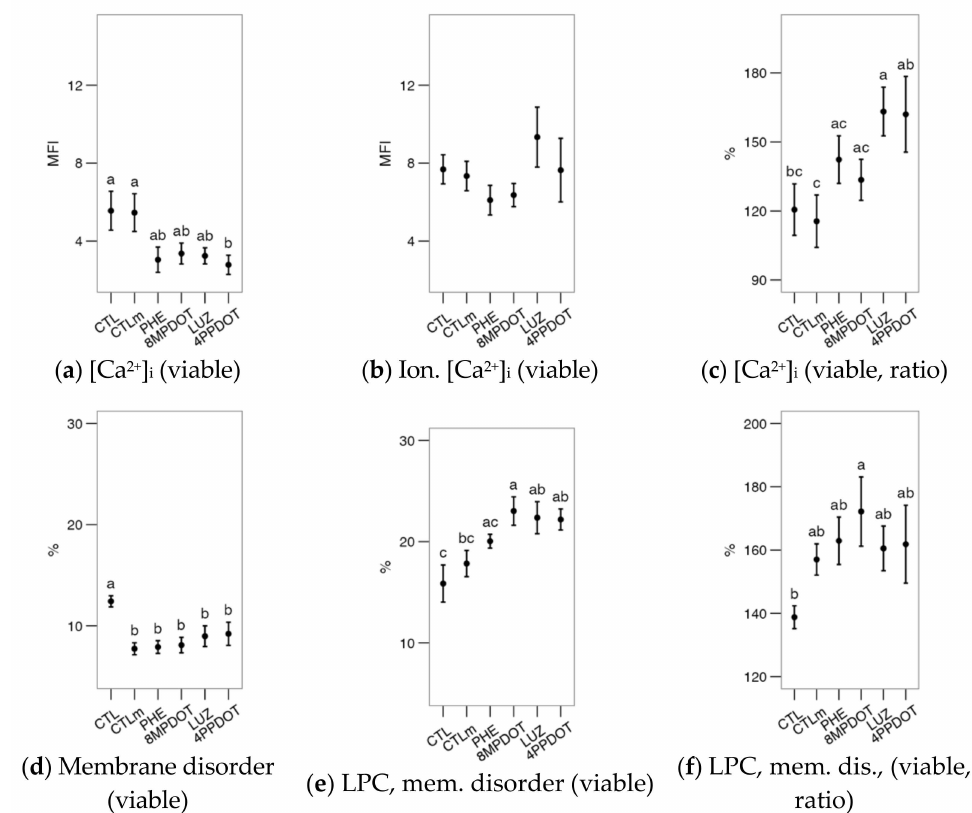
Figure 7. Effects on red deer epididymal sperm intracellular calcium ([Ca 2+ ] i ) and membrane lipidic disorder (within the viable population) of melatonin receptors agonists (PHE: Phenylmelatonin; 8MPDOT: 8-Methoxy-2-propionamidotetralin) or antagonists with 10 nM melatonin (LUZ: Luzin- dole; 4PPDOT: cis-4-Phenyl-2-propionamidotetralin); CTL: Control; CTLm: Control with 10 nM melatonin. Plots show mean ± SEM for each treatment of five different males. ( a ) Intracellular calcium concentration ([Ca 2+ ] i , from mean fluorescence intensity of Fluo-4 in viable spermatozoa); ( b ) Same parameter after ionophore treatment and ( c ) as ratio of the values after ( b ) and before ( a ) the challenge; ( d ) Proportion of cells with increased membrane disorder in the viable population (PI − ) as M540 + and ( e ) the same parameters after lysophosphatidylcholine (LPC) treatment and ( f ) as ratio of the values after ( e ) and before ( d ) the challenge. Treatments not sharing the same letters differ significantly ( p <